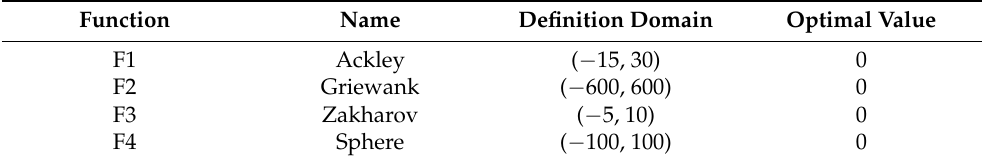
Table 1. Benchmark functions. Function